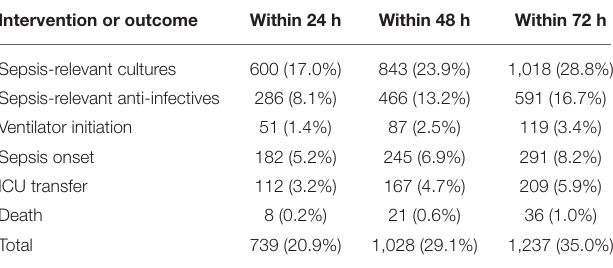
TABLE 2 | Pseudoprospective trial, outcomes for alerted